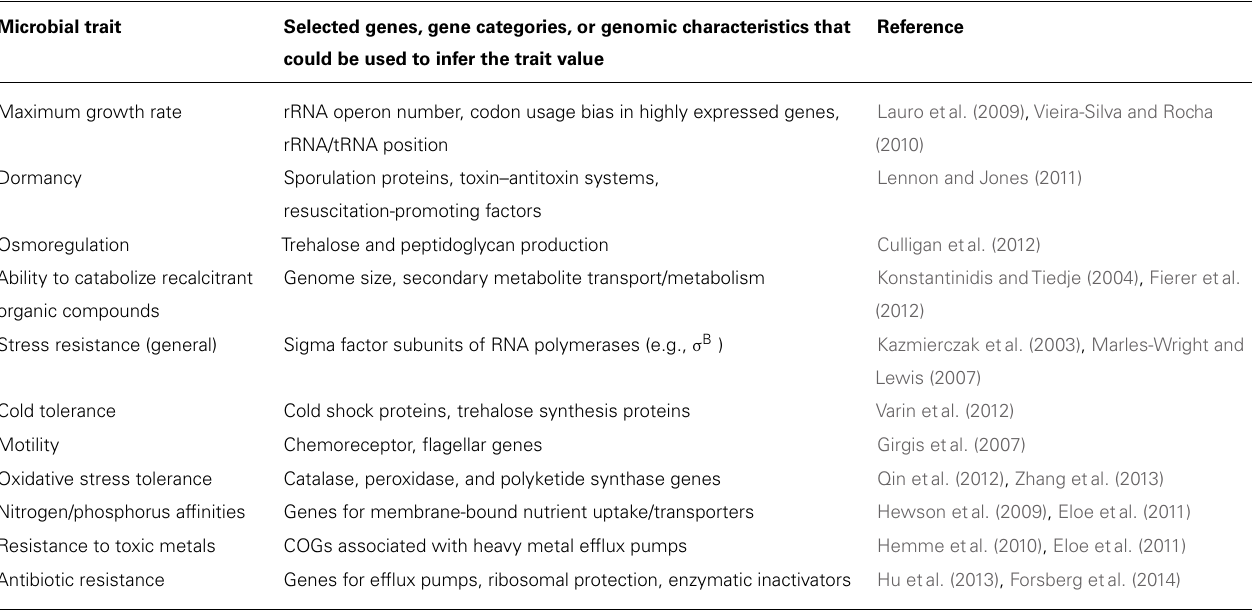
Table 1 | Selected examples of microbial traits and the genes or genomic characteristics that could be used to calculate community-aggregated trait (CAT) values from shotgun metagenomic data. Microbial trait Selected genes, gene categories, or genomic characteristics that could be used to infer the trait